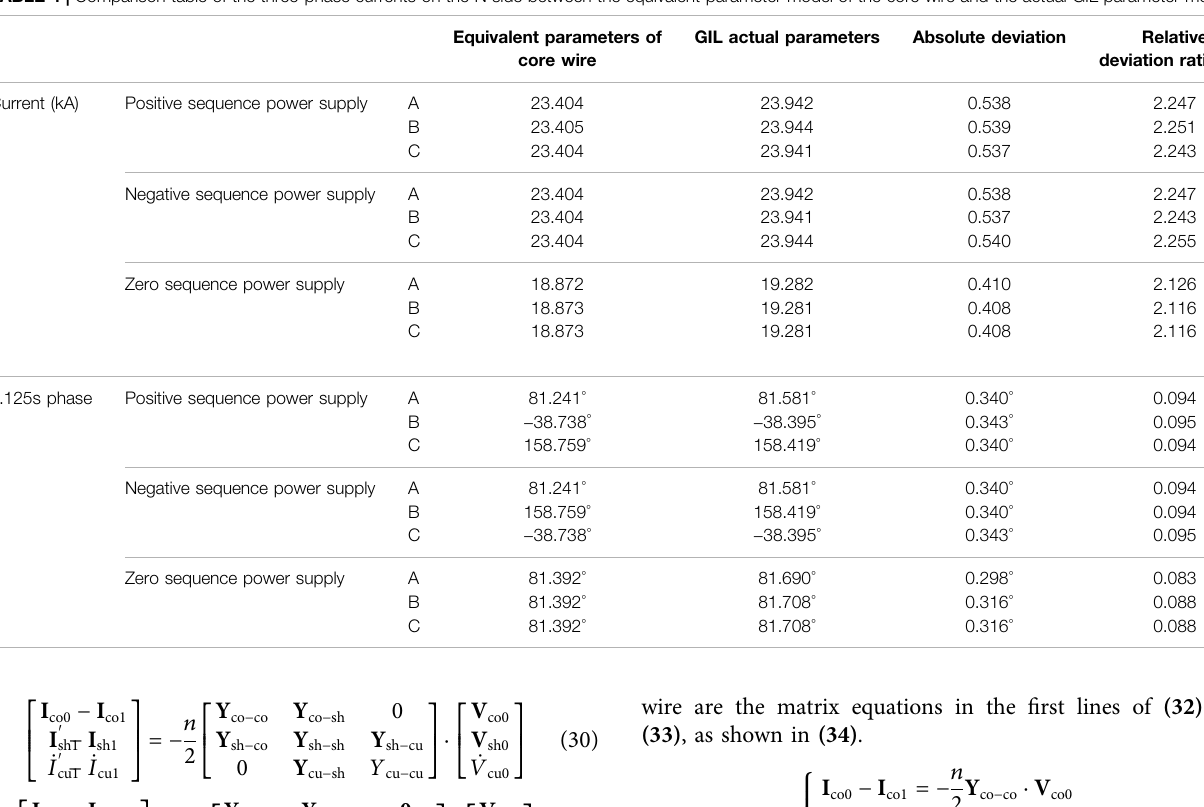
TABLE 4 | Comparison table of the three-phase currents on the N side between the equivalent parameter model of the core wire and the actual GIL parameter model.